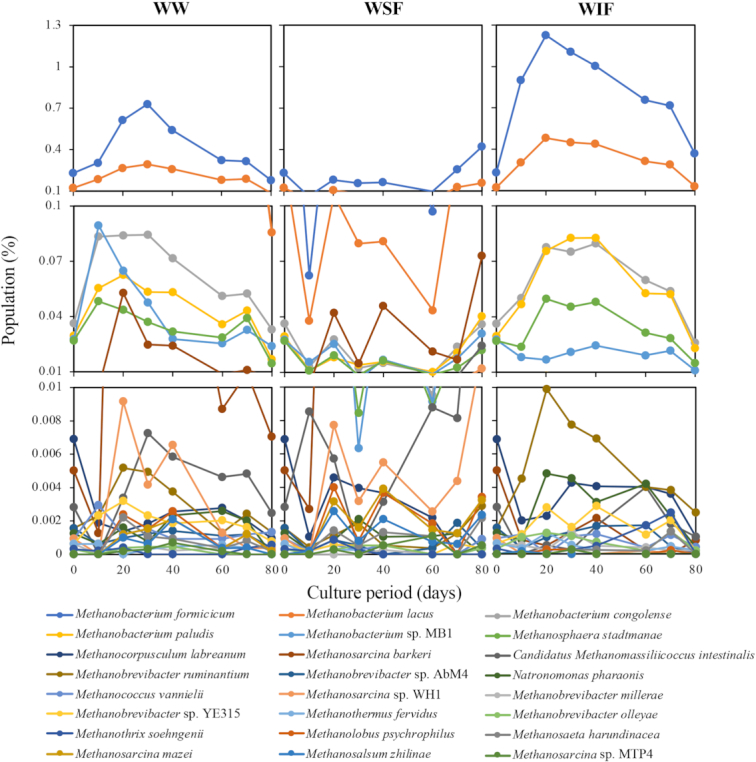
Changes in archaeal population at the species level in the cultures shown in Fig. 1. Populations of the species that once exceeded 0.001% in all-over culture are indicated in every culture.